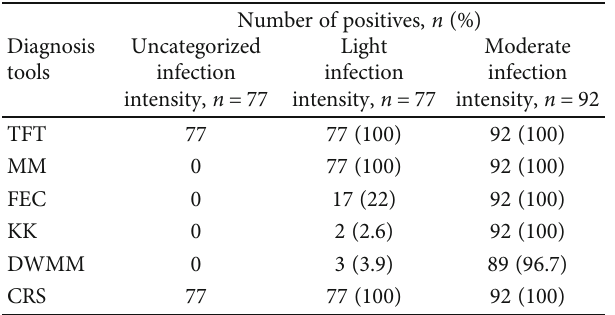
Table 3: Performance of hookworm diagnosis techniques based on the infection intensity category.